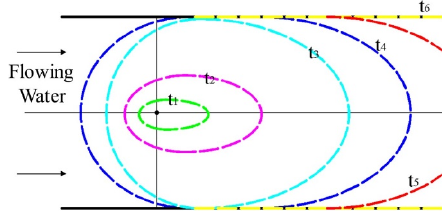
Figure 10. Schematic of the asymmetric ellipse diffusion process.